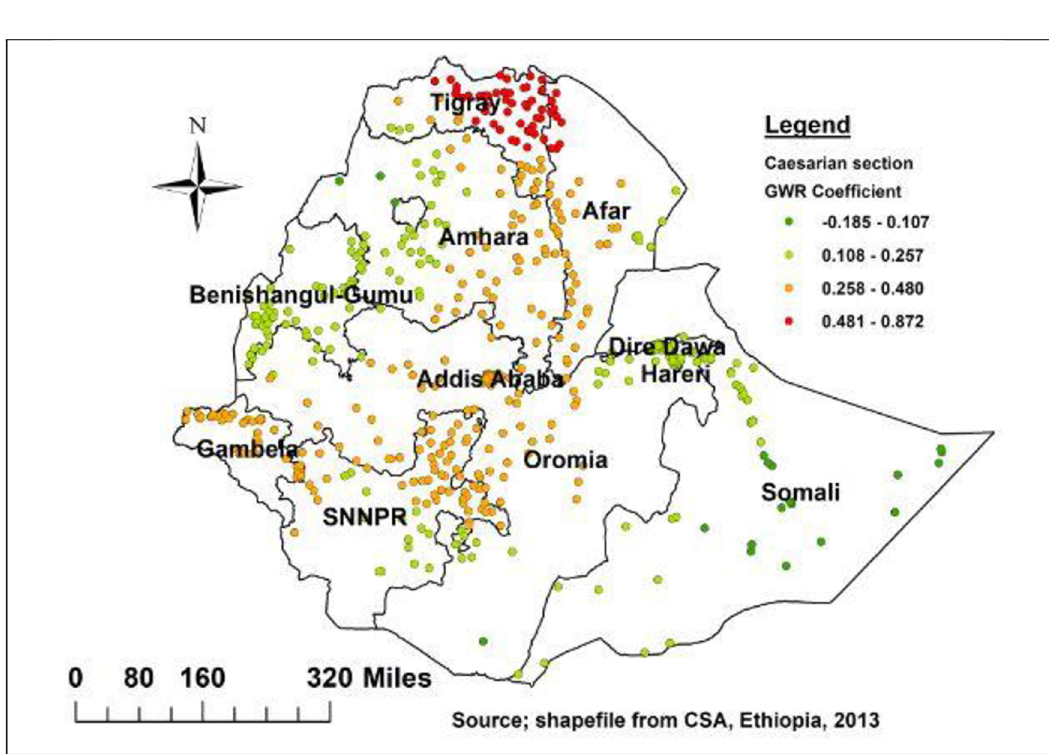
Fig 8. Caesarian section geographic weighted regression coefficients to predict delayed breastfeeding in Ethiopia.